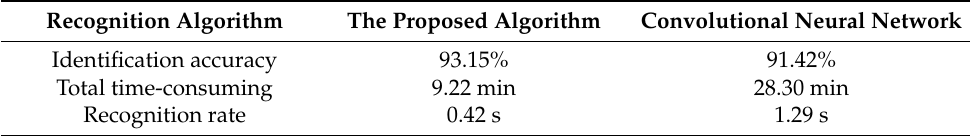
Table 5. Comparison of the proposed algorithm and deep-learning